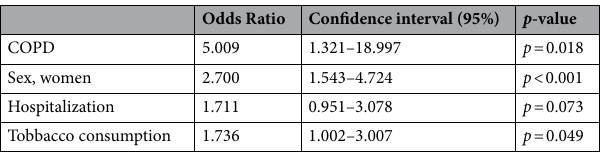
Table 4. Risk factors for long COVID. COPD chronic obstructive pulmonary